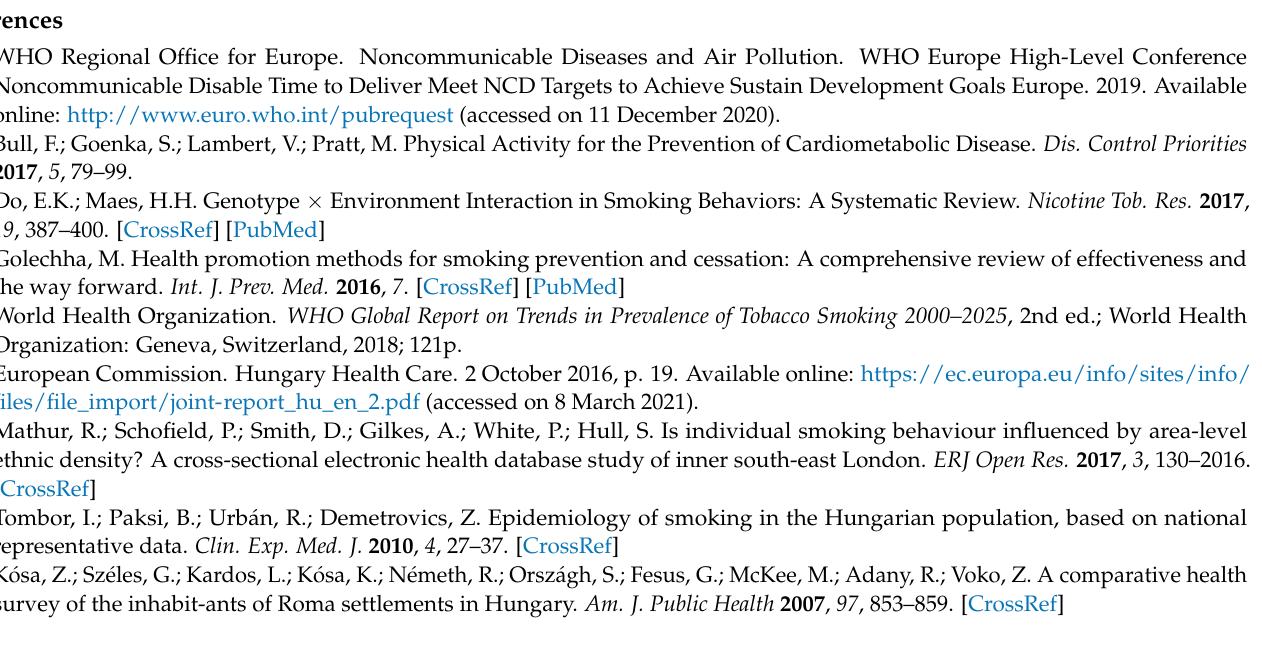
Regression model on age-imitation of smoking in both populations; Table S11: Socioeconomic status according to smoking status in both population; Figure S1: Cigarette per day (CPD) by genotype in the whole study sample; Figure S2: Cigarette per day (CPD) by genotype among HG (a1,2), (b1,2) among HR; Figure S3: Age at smoking initiation by genotype; Figure S4: Age at smoking initiation by genotypes among HG (a1,2), (b1,2) among HR; Figure S5: Frequency distributions of GRS and wGRS based on